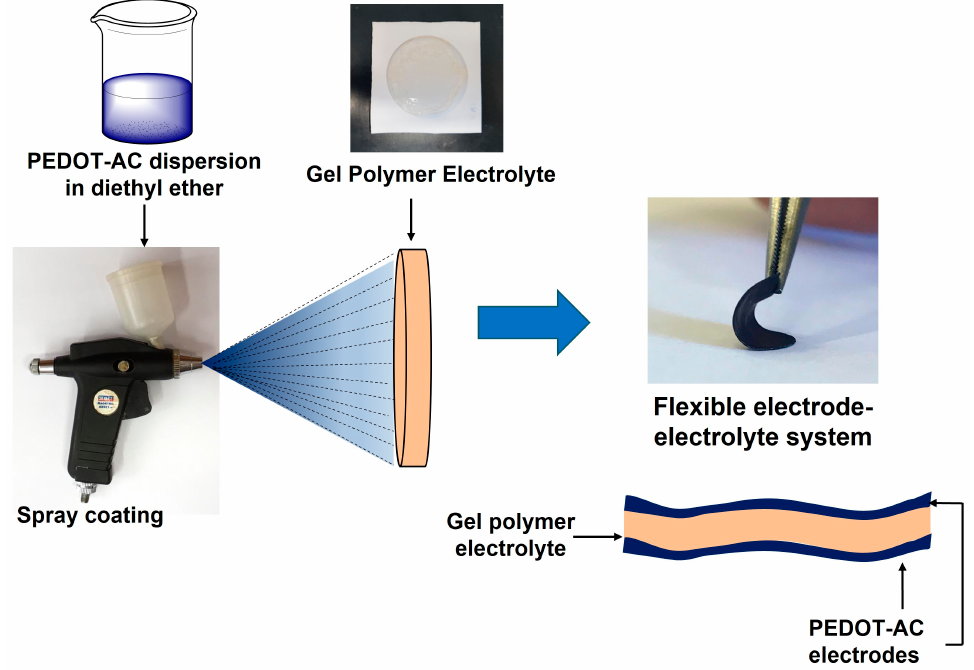
Figure 3. Scheme of preparation of poly(3,4-ethylenedioxythiophene) (PEDOT) and activated carbon derived from brewer’s spent grain. Reproduced from MDPI [15]. Table 5. Performance of biowaste-based nanocomposites.